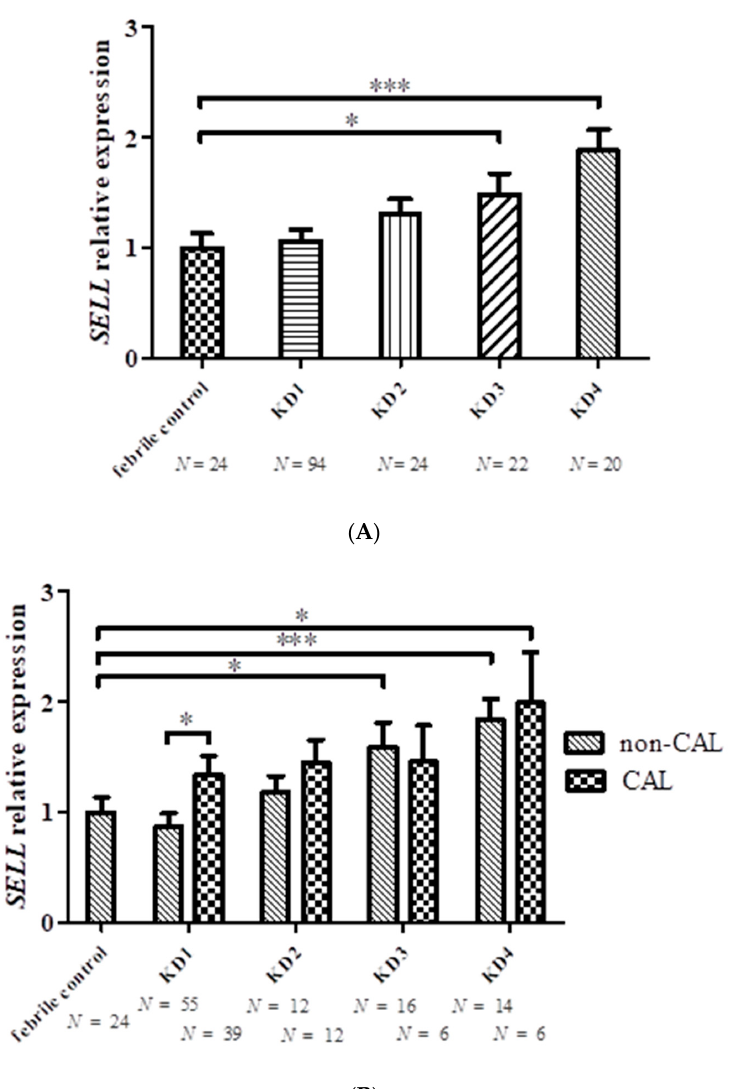
Figure 2. SELL mRNA levels ( A ) in febrile controls and patients with Kawasaki disease (KD1, before treatment; KD2, 3–7 days after treatment; KD3, three weeks after treatment; KD4, six months after treatment); ( B ) in KD patients with and without coronary artery lesions (CAL). * denotes significance (* p < 0.05; *** p < 0.001) between controls and KD patients, and KD patients with and without CAL.